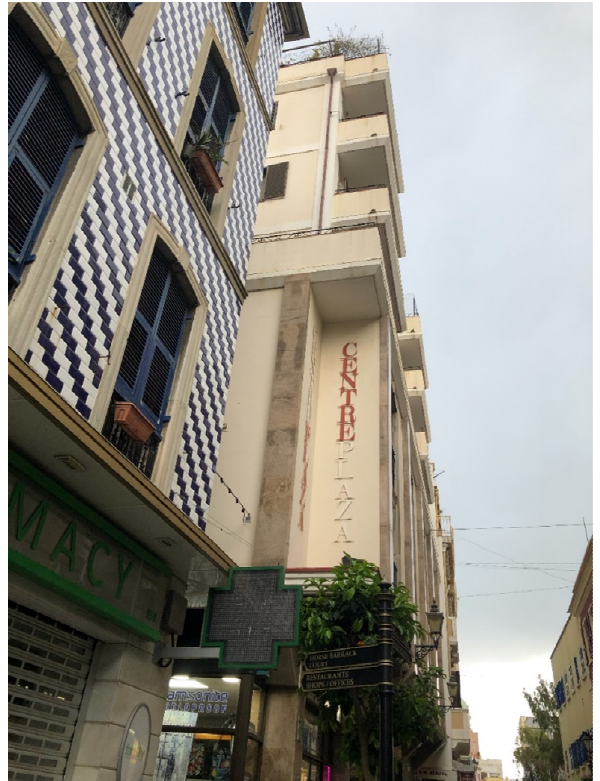
Figure 3. The Centre Plaza building, site of the Church of la Vera Cruz.